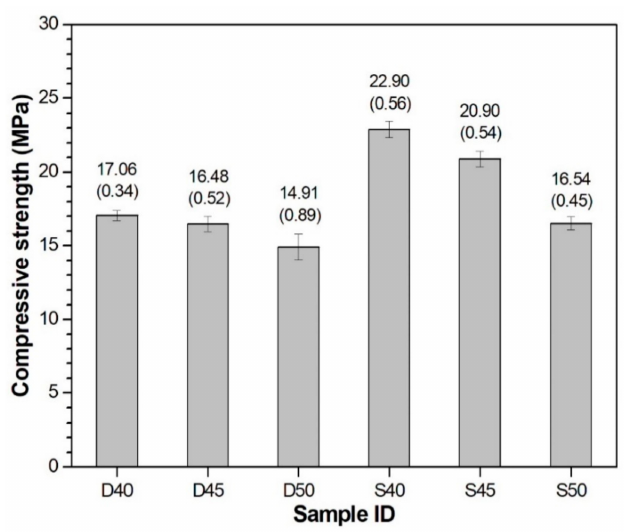
Figure 5. Compressive strengths at 24 h. The number above each bar indicates compressive strength testing result (standard deviation) in